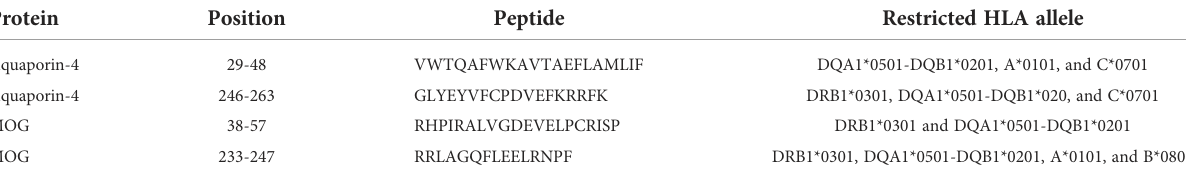
TABLE 6 Top predicted HLA class II binding peptides in AQP4 and MOG.